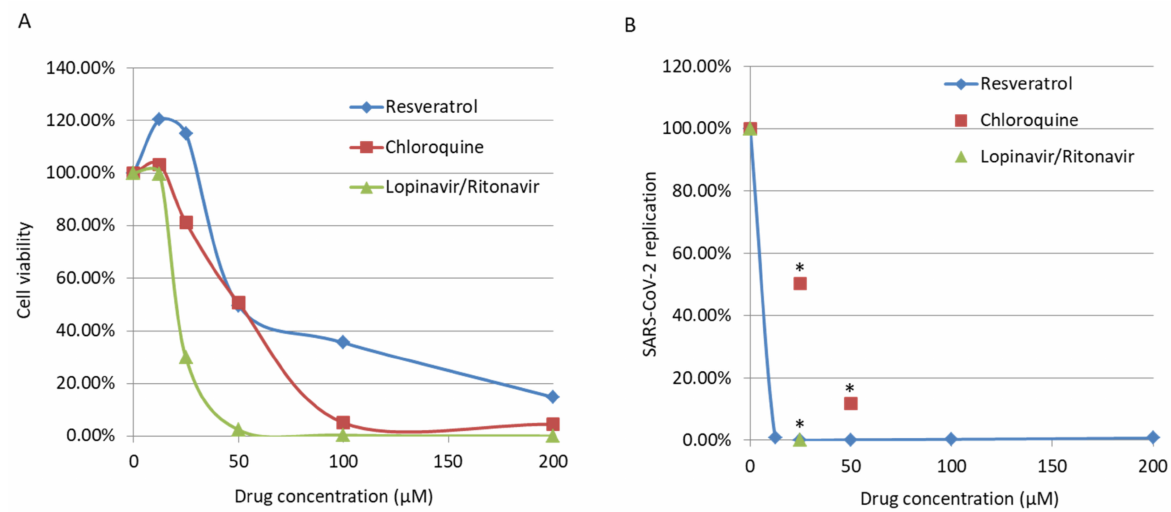
Figure 4. ( A ) Toxicity assay for Lopinavir/Ritonavir, Chloroquine and Resveratrol in Vero E6 cells, after 48 h. ( B ) Inhibition of severe acute respiratory syndrome coronavirus 2 (SARS-CoV-2) replication in Vero E6 cells treated with Resveratrol as mea- sured by qRT-PCR after 48 h. * Cytotoxicity impaired the evaluation of the anti-SARS-CoV-2 effect of Lopinavir/Ritonavir and